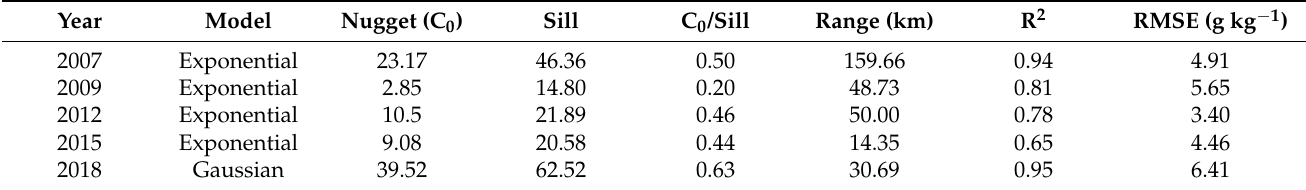
Table 4. Semi-variogram models of soil organic matter (SOM) in Lishu County.